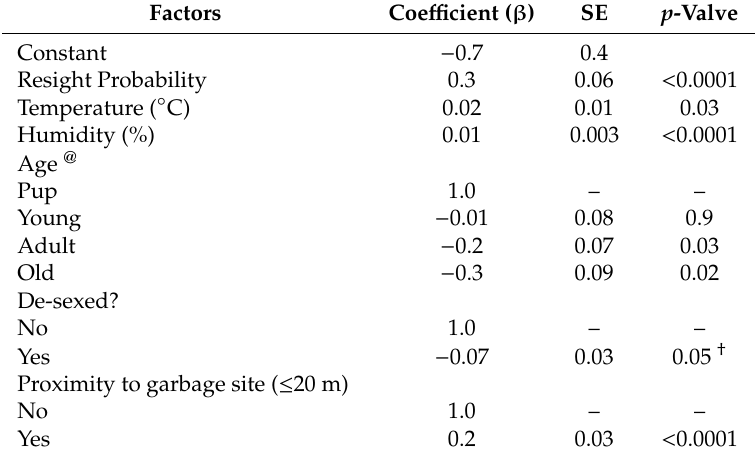
Table 5. Final multivariable model of predictors that significantly influenced the number of FRD sighted together (1 to 12) in an urban setting